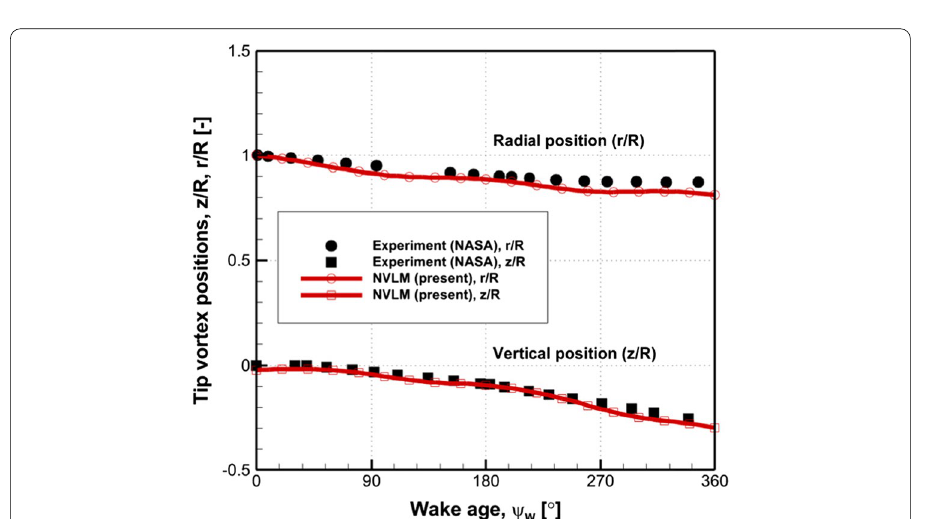
Fig. 9 Comparison of tip vortex trajectory in terms of radial and vertical positions for θ c